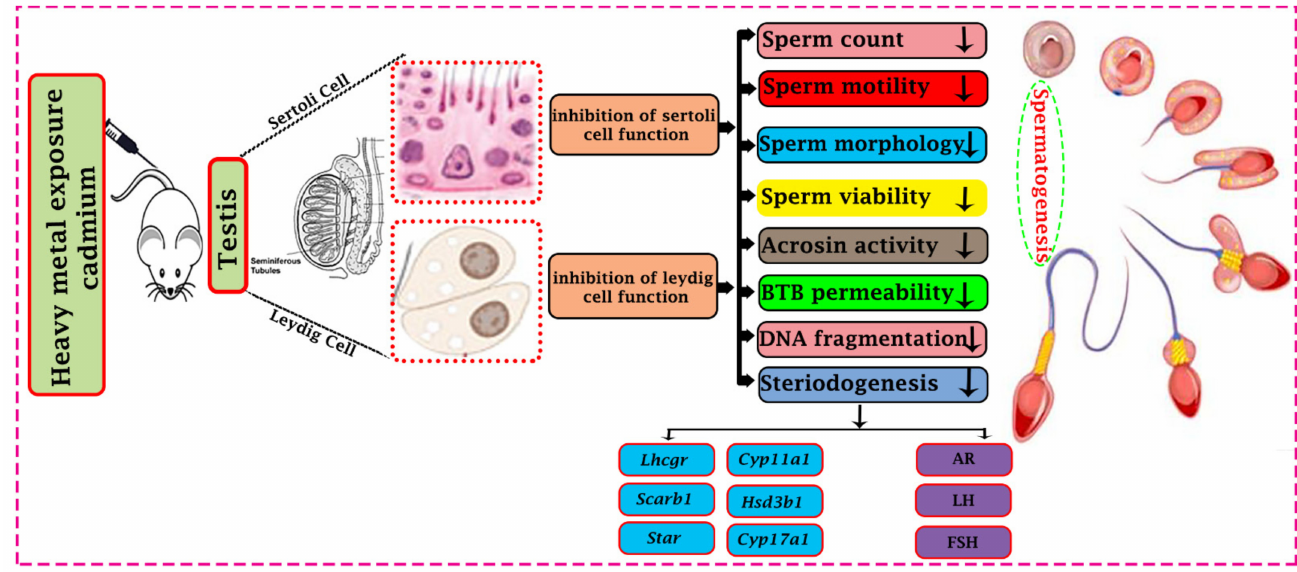
Figure 1. Effect of cadmium toxicity on the functional activity of a male reproductive organ. Cad- mium causes abnormal development and disturbs testicular cells’ functional activity (Sertoli cells and Leydig cells). Effects of Cadmium prohibit the different physiological processes like steroido- genesis and spermatogenesis. Cadmium reduces steroidogenic function by down-regulating the steroidogenic gene’s expression ( Lhcgr , Cyp11a1 , Scarb1 , Hsd3b1 , Star and Cyp17a1 ) and proteins like androgen, luteinizing hormone, and follicle-stimulating hormone (AR, LH, and FSH). Cadmium affects different developmental parameters of sperm and may lead to a reduction of spermatogenesis. In addition, cadmium causes impairment in the immune response through the Blood Testis Barrier (BBB) permeability. All these changes may impair the ability to